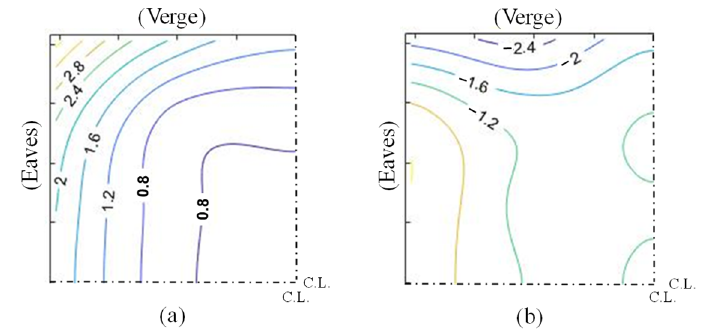
Figure 16. Contours of the most critical maximum and minimum peak wind force coefficients among all wind directions: ( a ) Maximum; ( b ) minimum.